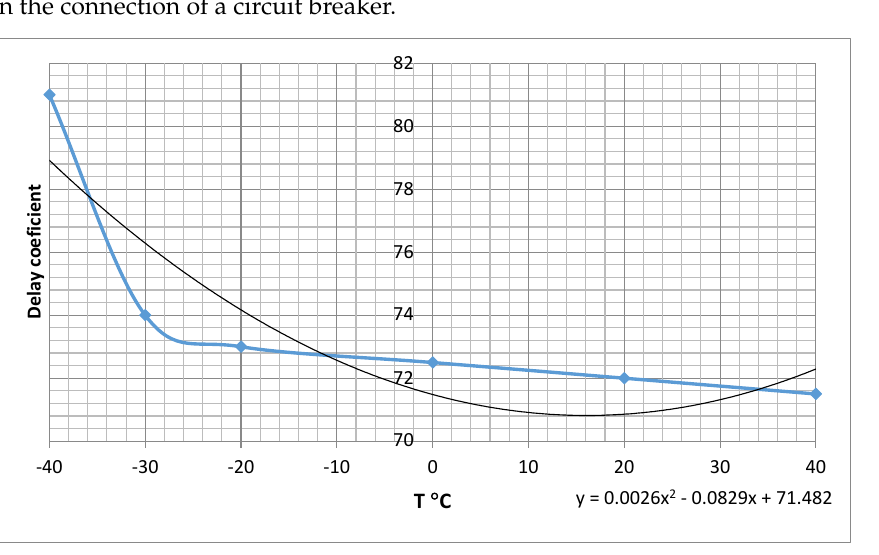
Figure 20. Dependency of C temp on the outdoor temperature on the connection of a circuit breaker. The DC voltage supply dependency of time coefficient t UDC = f (UDC) on the disconnection of a circuit breaker is represented in Table 8. Taking into consideration the measured values, the equation which describes the dependency is presented in Equation (21). Table 8. Measured values of the dependency of time coefficient on outdoor temperature.